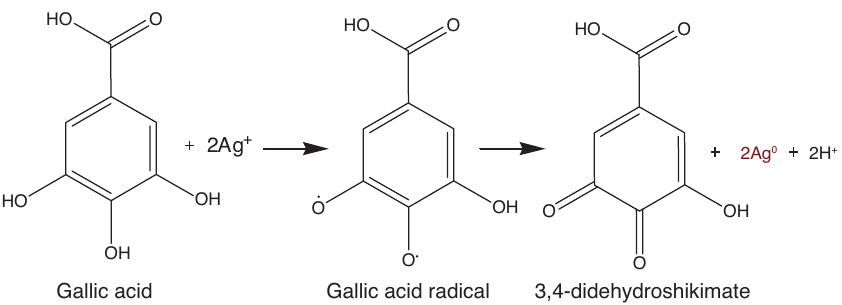
performed as FTIR spectroscopy is an important tool for the identification of the functional groups of biomolecules present in the plant extract. The major IR bands observed in the FTIR spectrum of the extract were 3278, 2915, 1640, 1519, 1423, 1269, 1064, 832, and 628 cm −1 as shown in Figure 2. The broad band observed 3278 cm −1 is the char- acteristic of the hydroxyl functional group of phenolic compounds and various carbonyl groups of the M. poly­ morpha leaf extract. The band at 2915 cm −1 was assigned to the stretching vibration mode of methylene groups (alkyl C–H group), whereas the stretching vibration bands at 1650 and 1519 cm −1 with bending vibration at 628 cm −1 were the characteristic of the amide I and II linkages of amino acids and proteins present in the extract. The band 1423 cm −1 corresponds to the C = C stretching vibration of aromatic rings. The band at 1269 cm −1 could be assigned to the C–O stretching vibration of carboxylic acids. The peak at 1064 cm −1 may be due to the C–N stretching vibration of aliphatic amines. The weak band at 832 cm −1 indicates the presence of stretching vibration of N–O species [23– 25]. These bands correspond to the –O–H, –C–N, –C = N, –C–H, –C–O, C–O–H, C = C, and N–O functional groups,